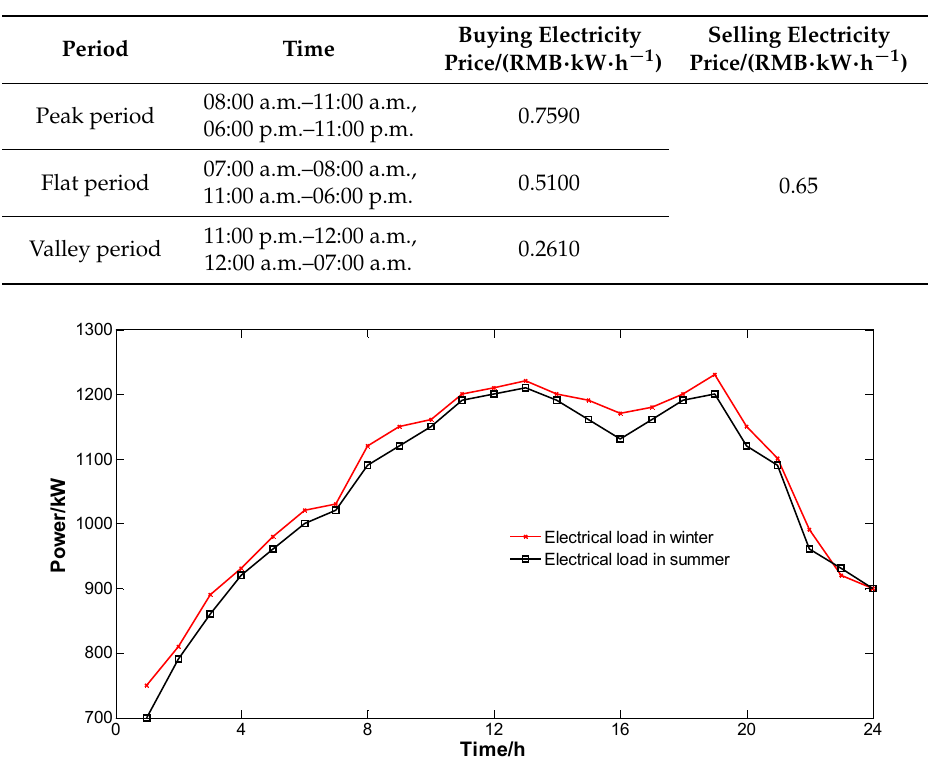
Figure 7. Electrical load curve of the distribution network on a typical day in the winter and in the summer.